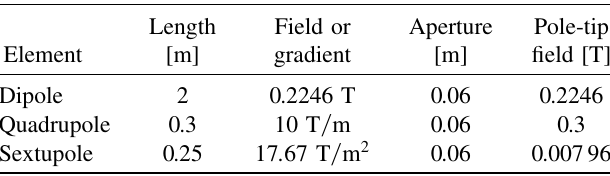
TABLE II. The parameters of the magnets.